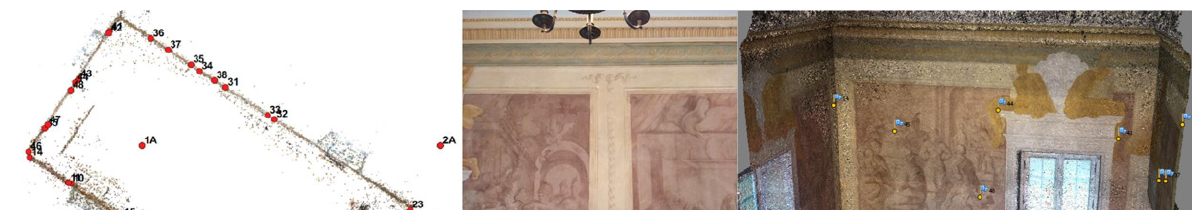
Figure 1. The example of frescoes which cover entirely the walls of a room